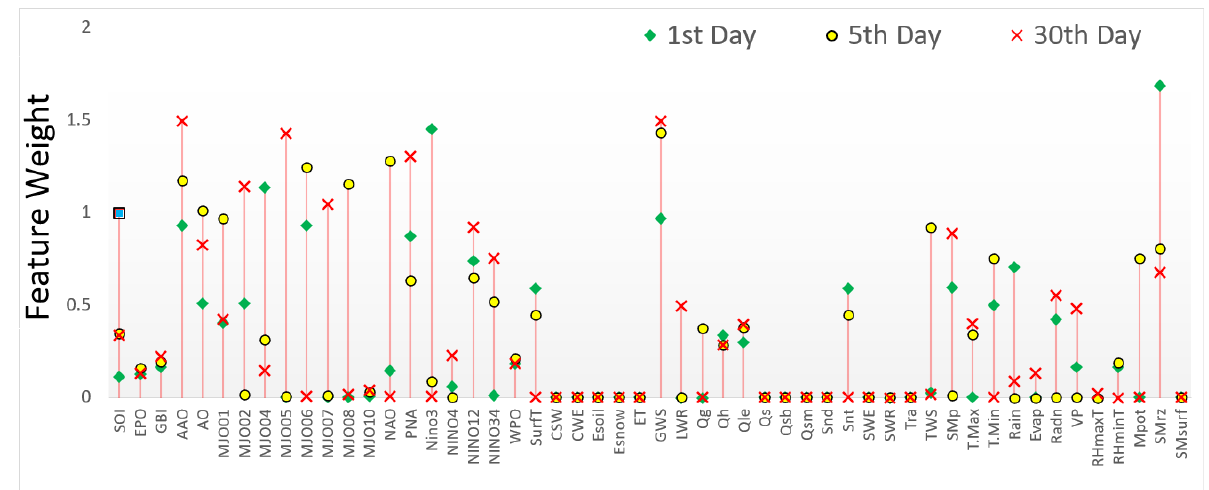
Figure 4. Feature weight matrix of predictor variables from a pool of 52 data sources using neighbourhood component analysis at the n th ( n = 1, 5, and 30) day lead time forecasting of surface soil moisture shown for the case of Menindee study station. Details of the variables are mentioned in Table 2.